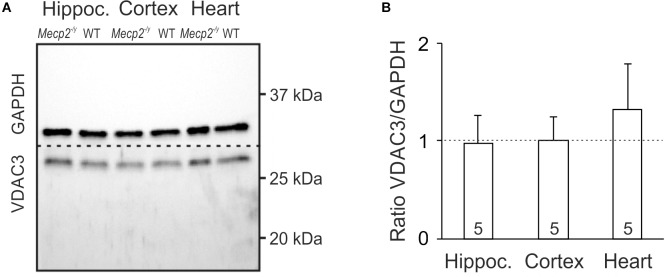
Mitochondrial mass is not altered in Mecp2-/y hippocampus and cortex. (A) In Western blot analyses, VDAC3 served as mitochondrial marker. Its expression was referred to GAPDH, and tissue lysates of hippocampus, cortex, and heart were compared among WT and Mecp2-/y siblings. Dashed line indicates the membrane cut after protein blotting. (B) In densitometric analyzes genotypic differences for hippocampus and cortex were not found. Mitochondrial mass tended to be higher though in Mecp2-/y heart (n = 5 mice each). Plotted VDAC3/GAPDH ratios are normalized to WT conditions (defined as unity, see dashed line), statistical significance was assessed by one-sample t-tests.